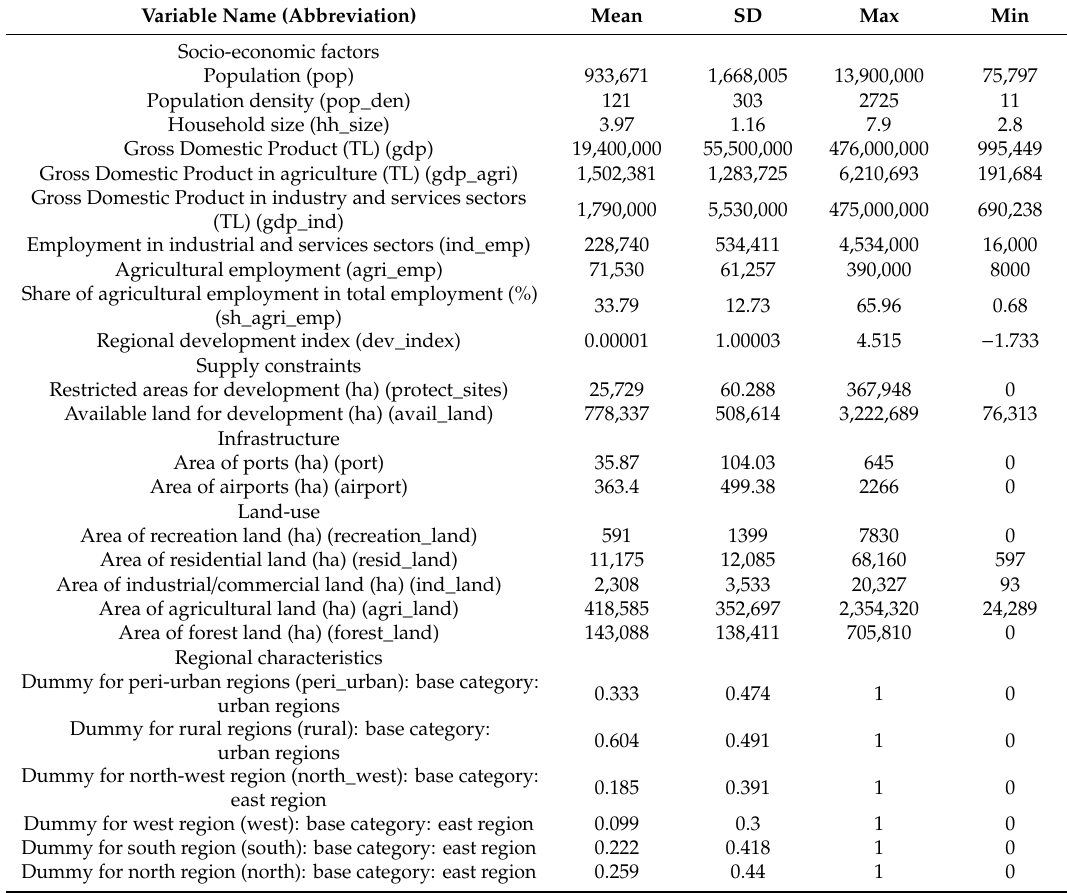
Table 6. Descriptive statistics of